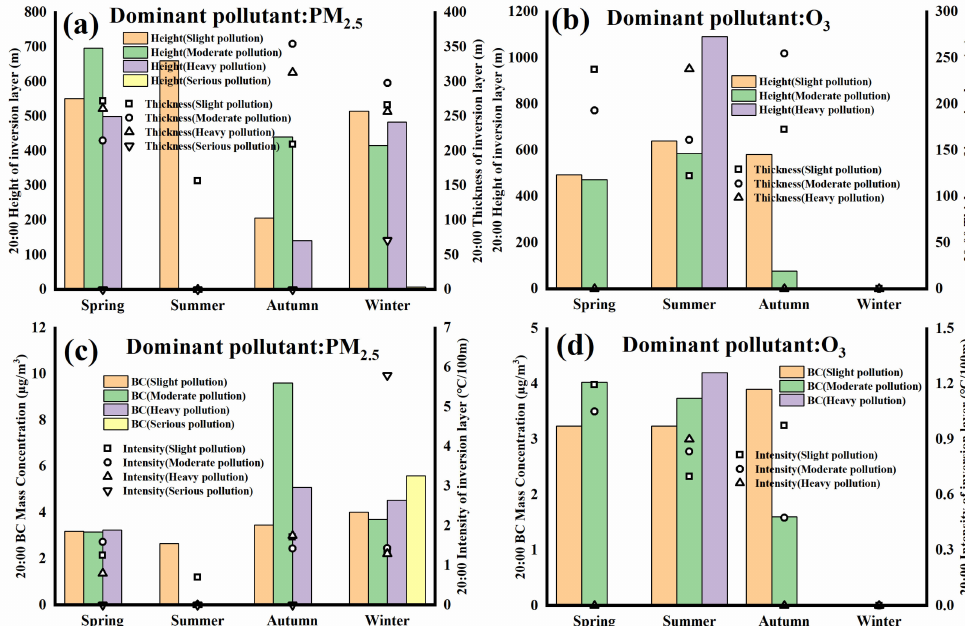
Figure 8. ( a ) Seasonal variations in inversion layer height and inversion layer thickness at 20:00 for the dominant pollutant PM 2.5 at different air quality levels in 2015–2020; ( b ) Seasonal variations in inversion layer height and inversion layer thickness at 20:00 for the dominant pollutant O 3 at